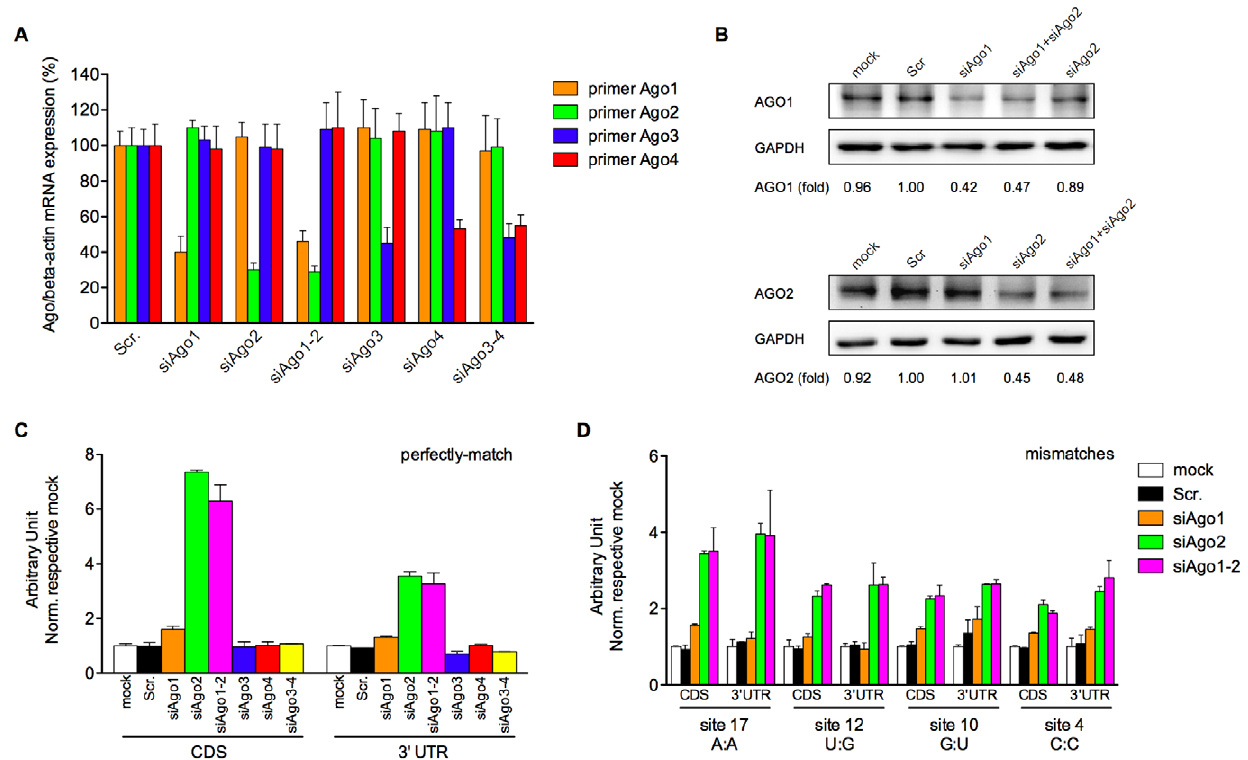
Figure 4. AGO2 contributed predominately to silencing activity in both regions. (A) The relative AGO mRNA levels were measured by quantitative RT-PCR 24 hours post siAgo transfection. Results were average values of assays in triplicates, and all experiments were repeated three times. (B) The relative AGO protein levels were detected by western blot 56 hours post siAgo transfection, at the time point when AGO ablated cells were harvested to evaluate luciferase activities. GAPDH was included as loading control. The intensity of protein bands was quantified by ImageJ software (NIH, USA). All experiments were performed at least twice. (C) The normalized silencing efficacies of siR-04 on perfectly matched target in CDS versus 3 9 -UTR after AGOs ablation. Silencing of AGO expression was carried out by gene-specific siRNA assessed in the previous study [9], and subsequently, influence of the gene silencing on perfectly-match tolerance was evaluated by reporter system. All data were normalized to mock. (D) The normalized silencing efficacies of siR-04 on single-nucleotide mismatched target sites in CDS versus 3 9 -UTR at the indicated positions (4C, 10U, 12G, 17A) after AGOs ablation. The target site location and siRNA:mRNA match pattern were given under the x-axis. Error bars represented SD. Data were average values of assays in triplicates, and all experiments were repeated at least